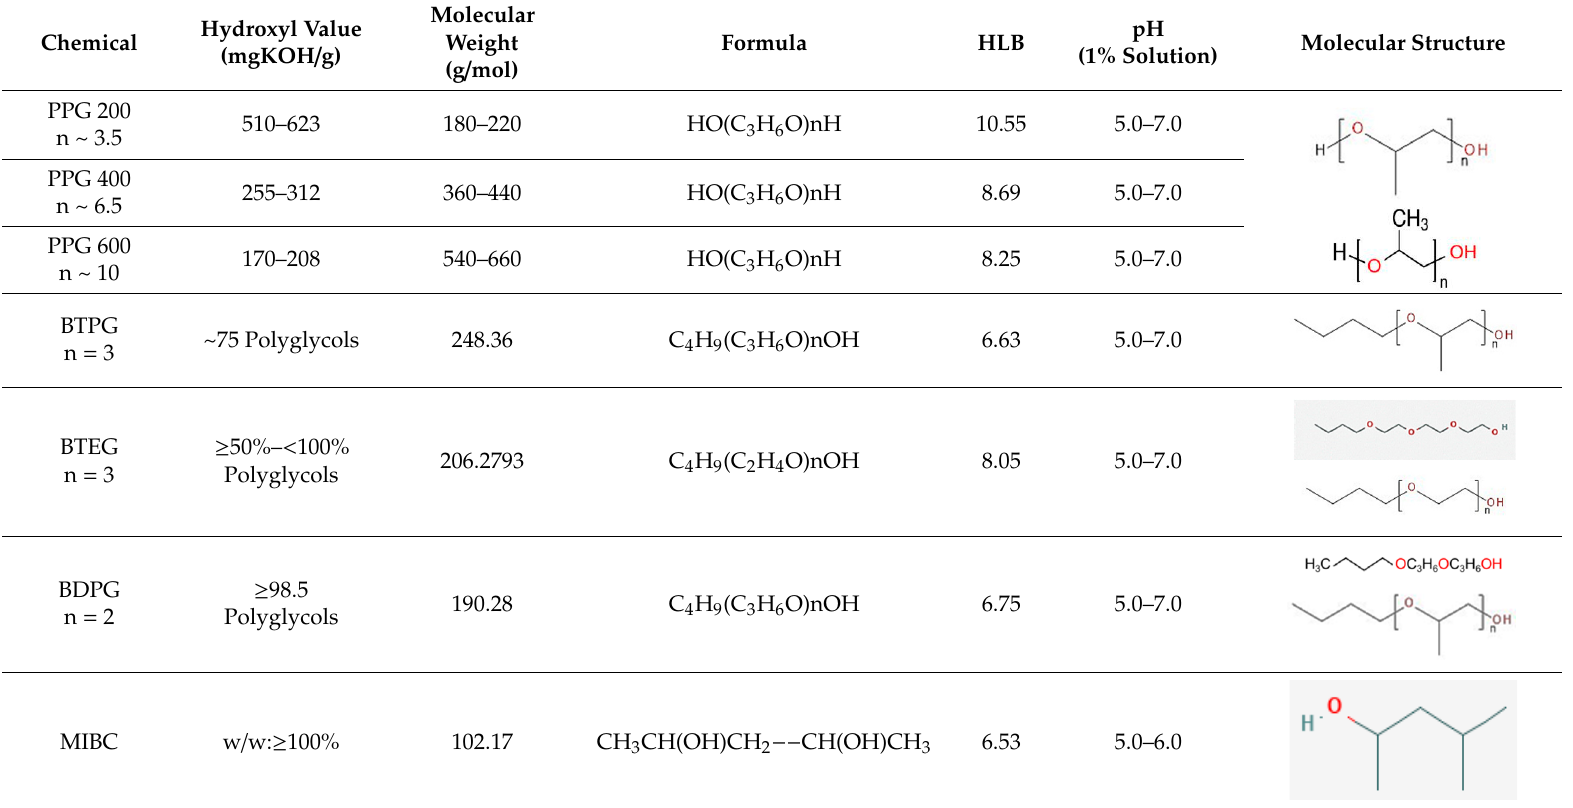
Table 1. Physical and chemical properties of frothers.